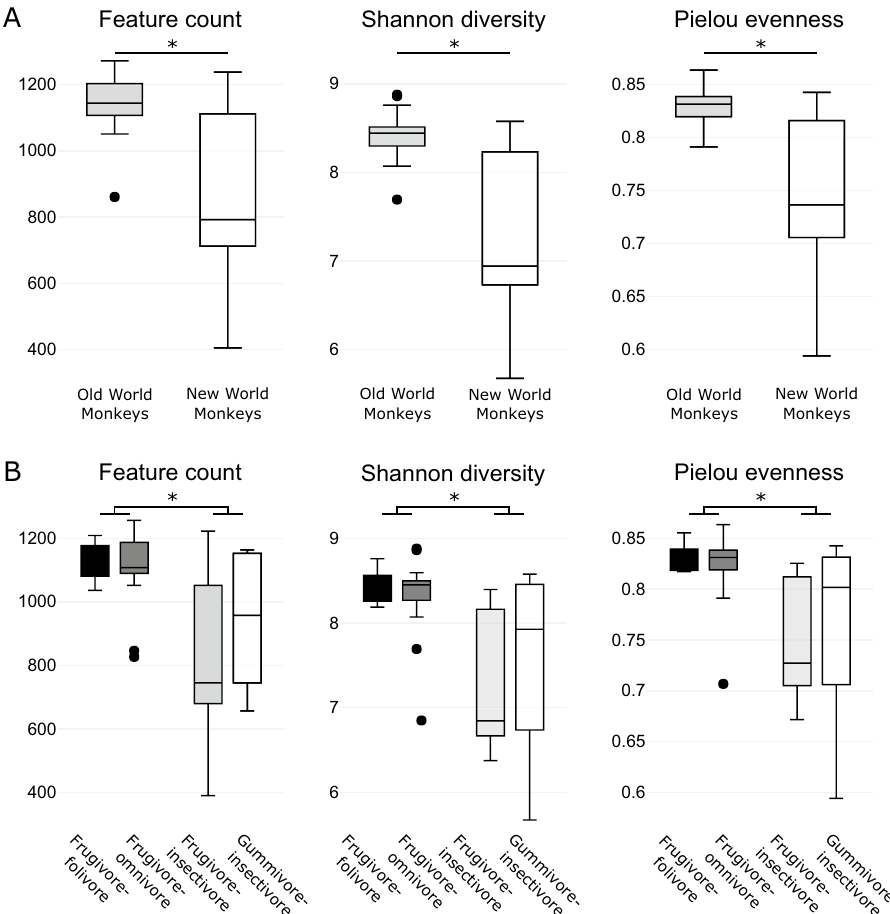
Figure 3. Alfa-diversity of primate gut microbiota. ( A ) Bacterial α-diversity per parvorder: New World monkeys and Old World monkeys. ( B ) Bacterial α-diversity per feed category: frugivore-folivore, frugivore- omnivore, frugivore-insectivore, gummivore-insectivore. Asterisks (*) denote adjusted statistically significant differences (adj. p <